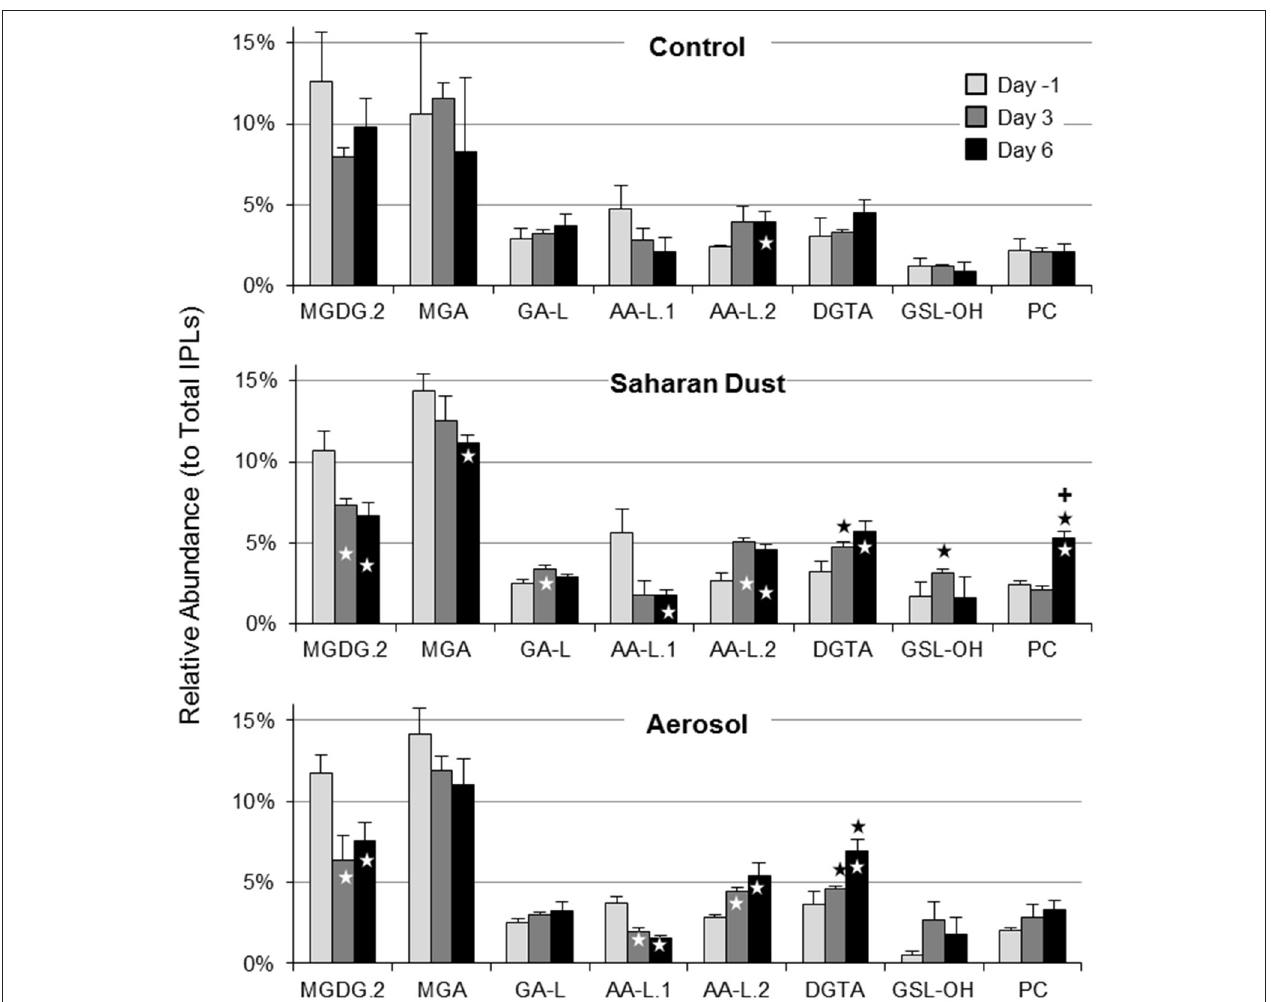
FIGURE 7 | Average relative abundance of selected IPLs in control, Saharan dust, and mixed aerosol mesocosms. Significant differences relative to the control or between Saharan dust and mixed aerosol treatments are indicated by black stars or plus symbols, respectively. Significant changes relative to the day − 1 sample for each treatment are indicated by white stars. Error bars indicate one standard